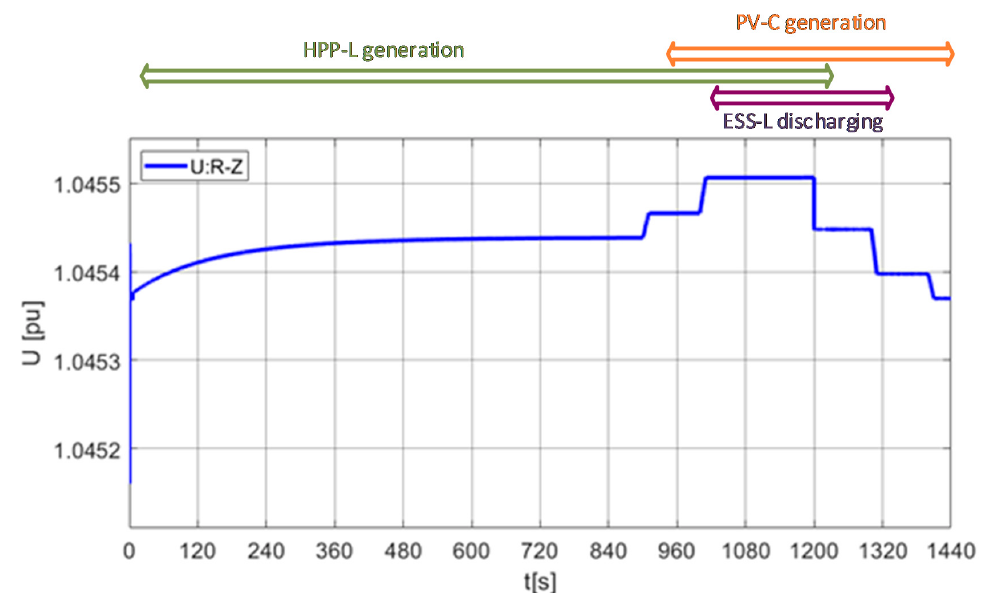
Figure 10. Voltage changes U at the secondary side of the HV / MV transformer in the main station R-Z during the series of switching operations of HPP-L , PV-C and ESS-L .